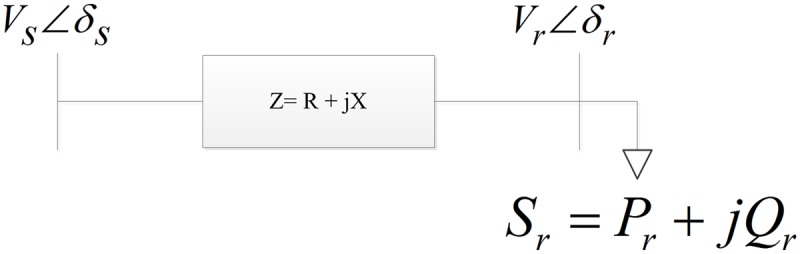
Two bus network.